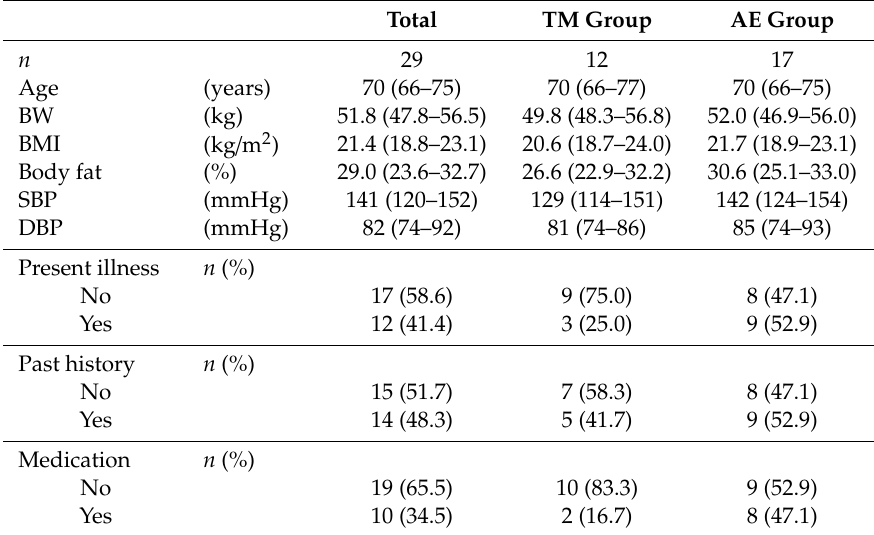
Figure 2. Flowchart of the screening, enrollment, intervention, and data analysis of the study. Abbreviations: TM, trunk muscle training; AE, aerobic exercise training. Table 1. Clinical characteristics of the subjects.